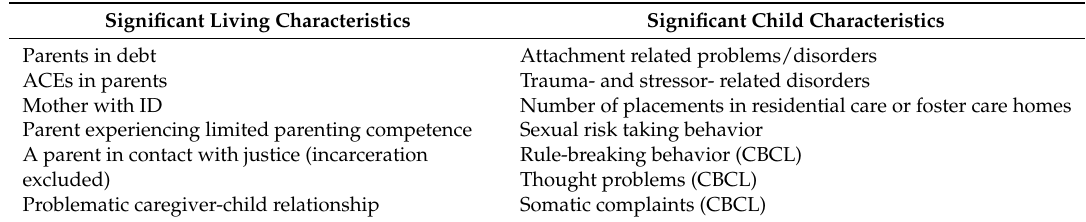
Table 4. Significant living circumstances and child characteristics (< 0.05) on the number of ACEs in children with